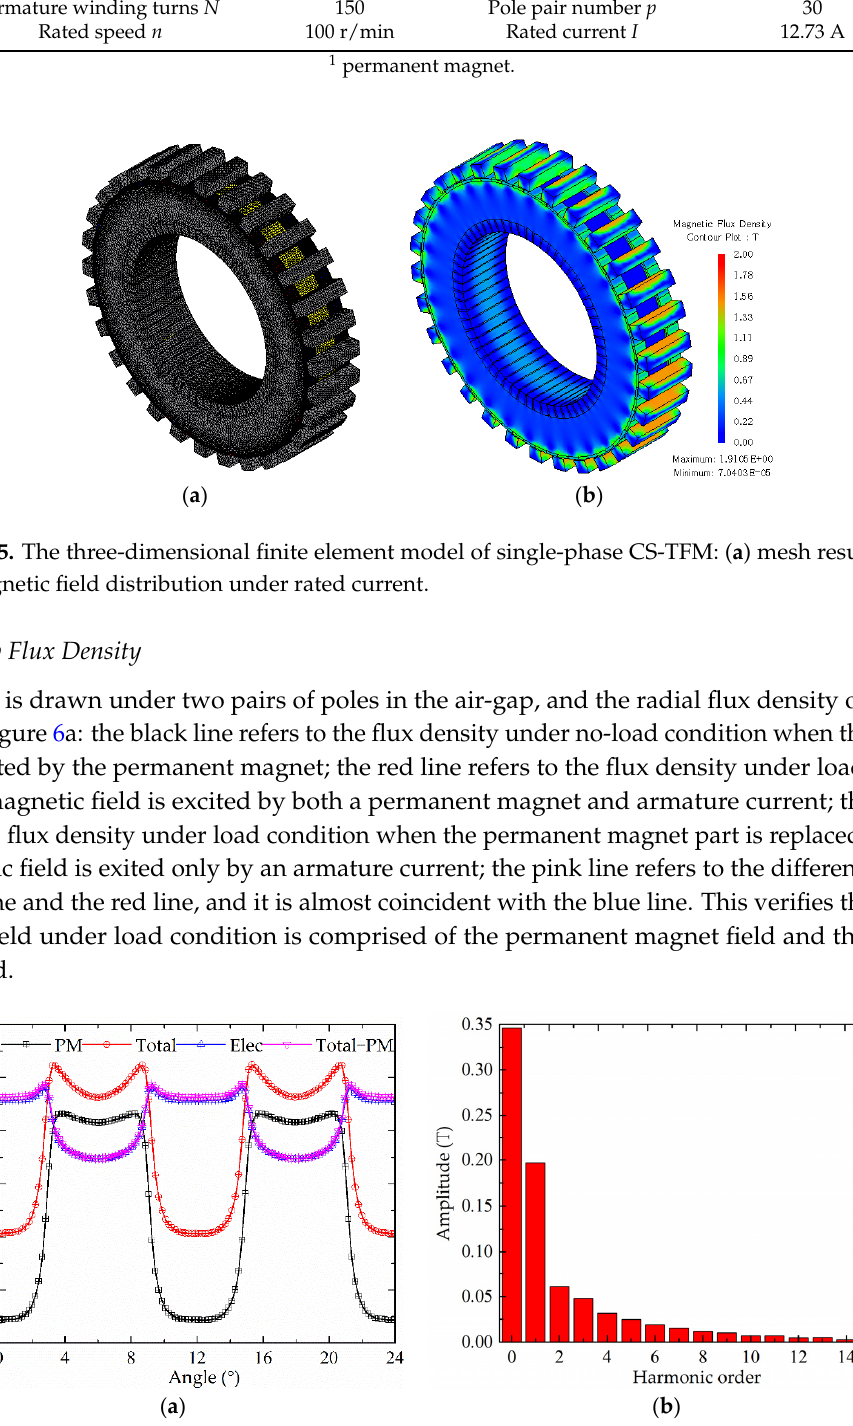
Figure 6. The radial flux density of air ‐ gap: ( a ) waveform; and ( b ) harmonic components.